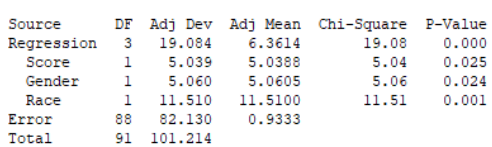
Figure 6. Deviance table for the logistics regression